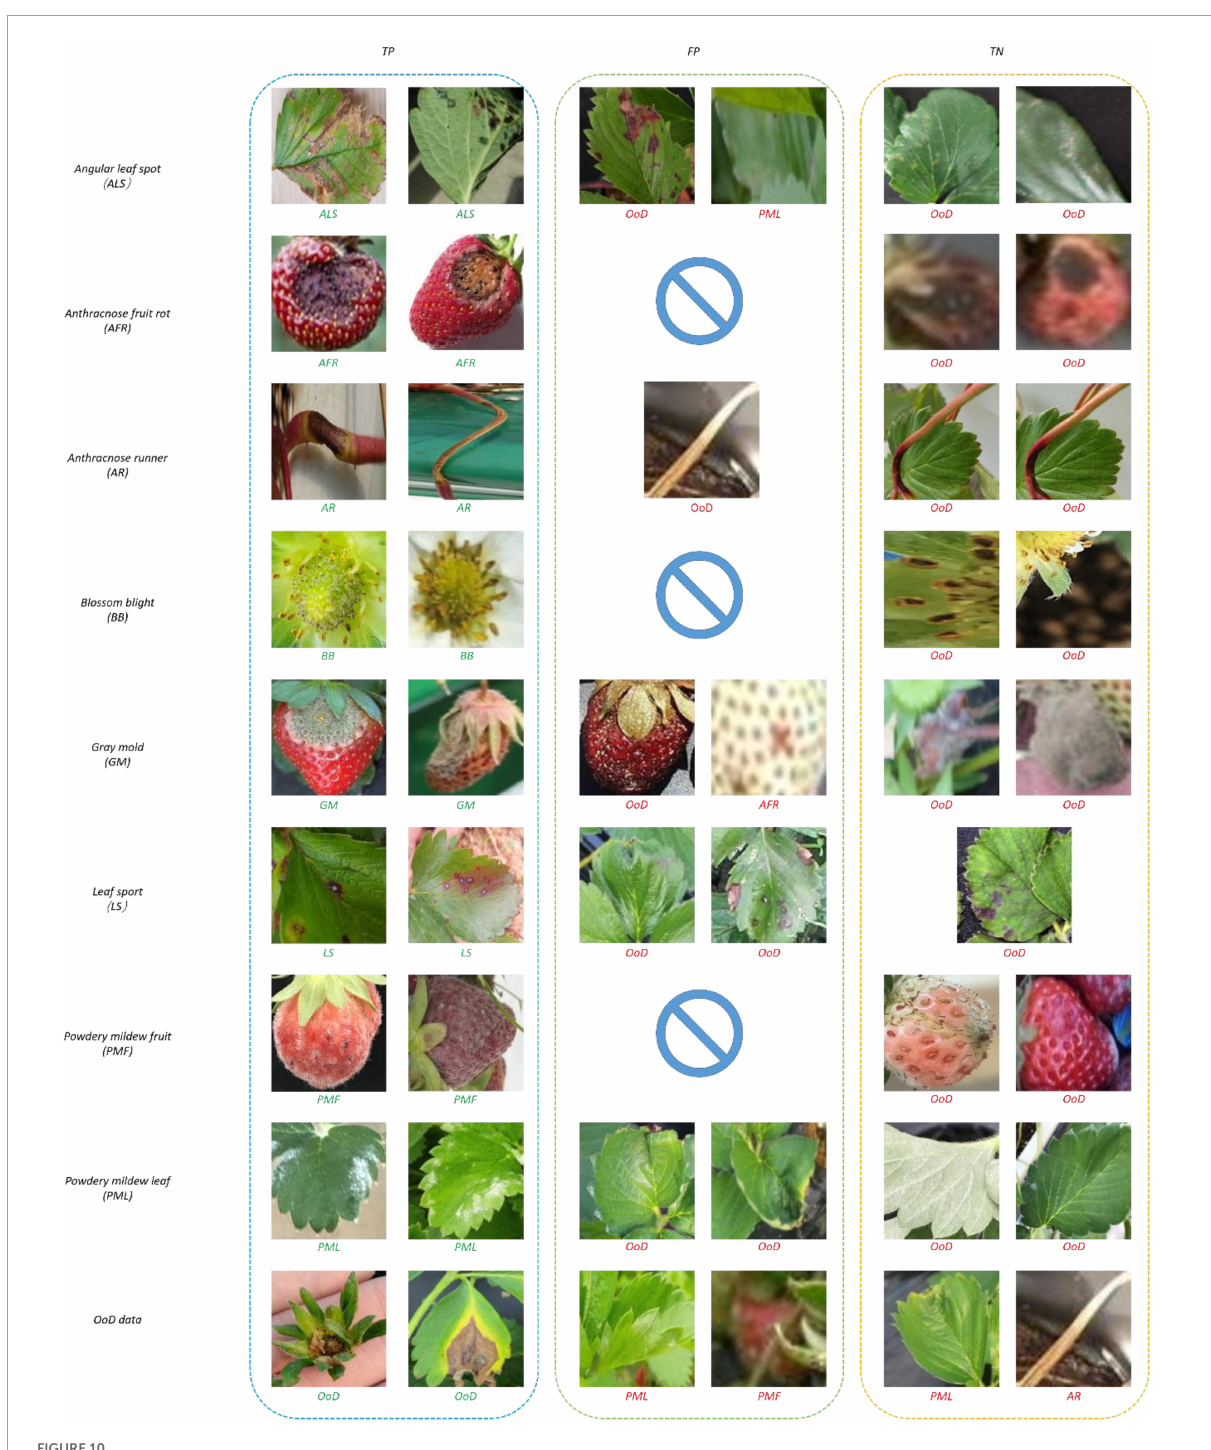
FIGURE10 Recognition results of correct and incorrect classification.